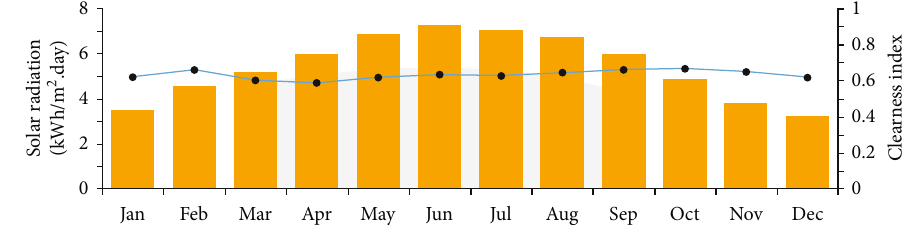
Figure 4: Solar radiation and clearness index pertaining to the city of Yazd. Table 2: Technical and economic analysis of the proposed system under scenario